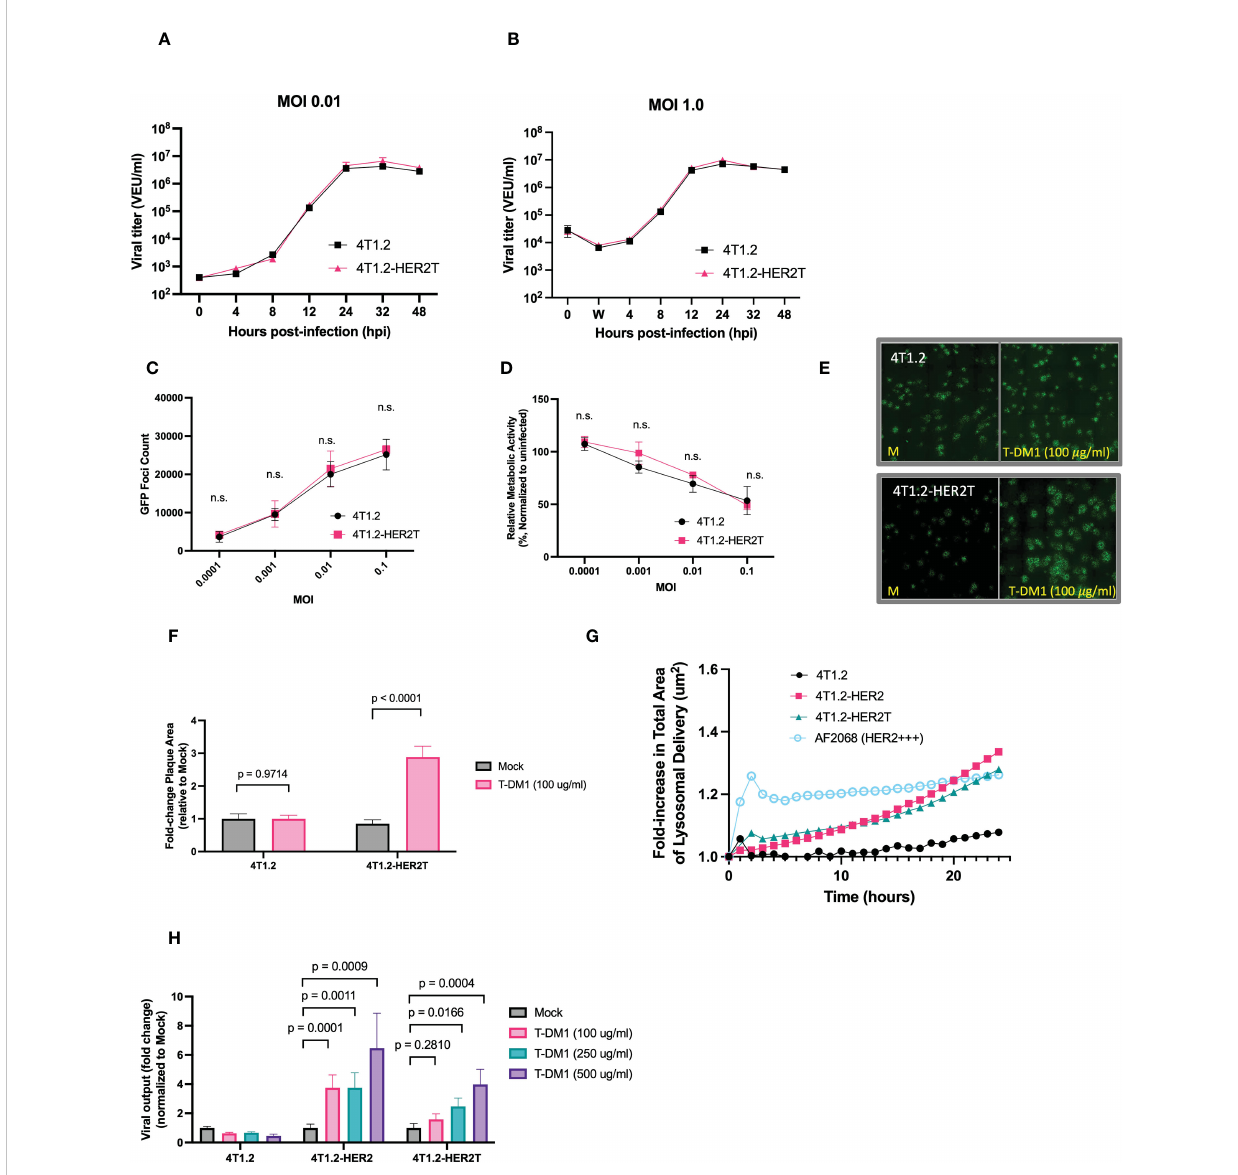
FIGURE 5 4T1.2-HER2T cells are sensitized to VSV D 51 infection following treatment with T-DM1. (A, B) 4T1.2 or 4T1.2-HER2T cells were infected at (A) low or (B) high MOI with VSV D 51-Fluc. Viral supernatant was collected at the indicated timepoints and viral titer was quanti fi ed. (C, D) Cells were infected with different MOI of VSV D 51-GFP. (C) GFP foci were counted at 24 hpi, and (D) viability of infected cells was assessed by AlamarBlue at 48 hpi (n=3 per MOI; mean ± SEM; n.s. by multiple unpaired two-tailed t-tests). (E) Plaque expansion assay of the indicated cells. Monolayers were treated as indicated then infected with VSV D 51-GFP at MOI 0.001 for 45 minutes. Viral supernatant was removed and a 0.5% agarose-DMEM overlay was added. Cells were incubated for 48 hours then imaged. (F) Plaque diameters from (E) were quanti fi ed using ImageJ and fold change calculated (mean ± SEM; n=3 wells, 40 plaques quanti fi ed randomly per well, two-way ANOVA, Sidak ’ s correction for multiple comparison) (G) trastuzumab internalization assay; cells were incubated with a pH-sensitive internalization reagent mixed with trastuzumab, incubated for 24 hours, and imaged at 30-minute intervals. Pixel intensity was quanti fi ed. (H) The indicated cell lines were treated as shown, then infected with MOI 0.01 VSV D 51-Fluc. Virus titer was quanti fi ed 48 hpi (mean ± SEM; n=3 wells; two-way ANOVA with Dunnett ’ s correction for multiple